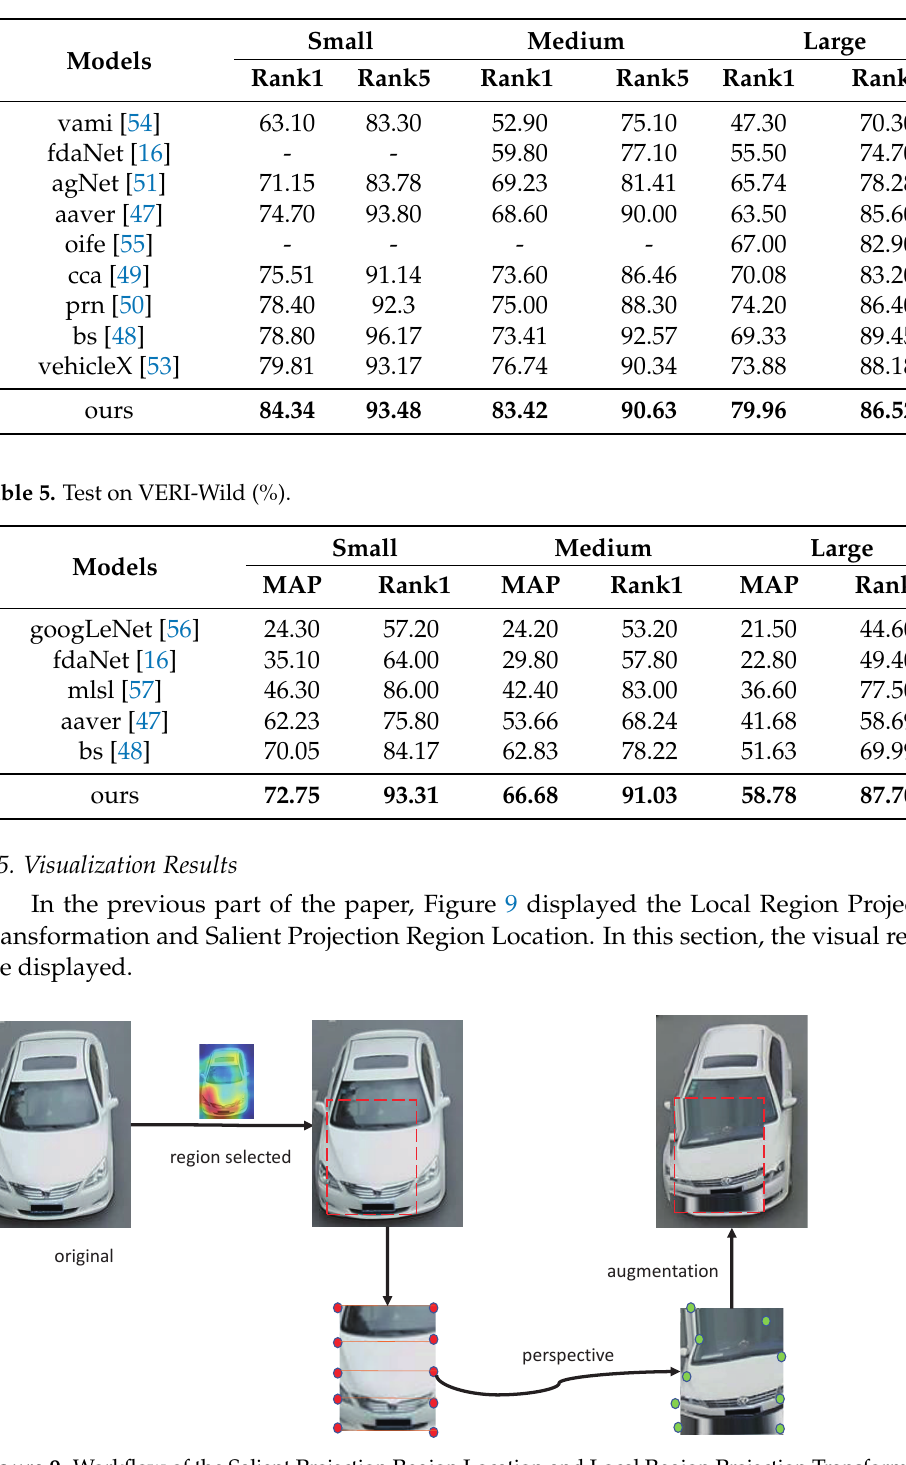
Figure 9. Workflow of the Salient Projection Region Location and Local Region Projection